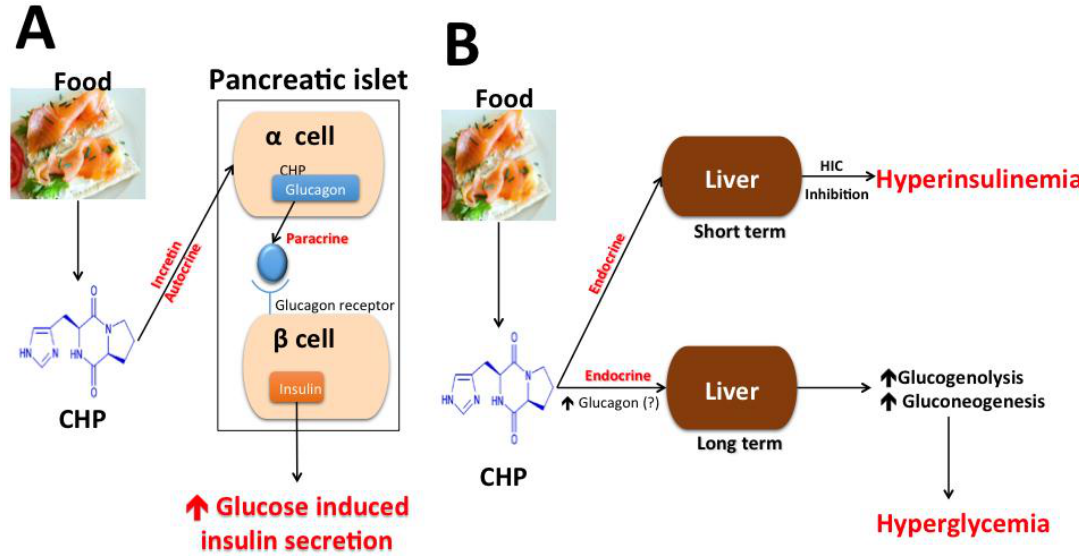
Figure 1. A diagrammatic representation of actions of Cyclo (His-Pro) at the level of the pancreas and liver in controlling insulin secretion and glucose metabolism. CHP = Cyclo (His-Pro). Panel A refers to action of CHP on pancreatic α and β cells via autocrine/incretin mechanisms. Panel B refers to short-term and long-term actions of CHP on